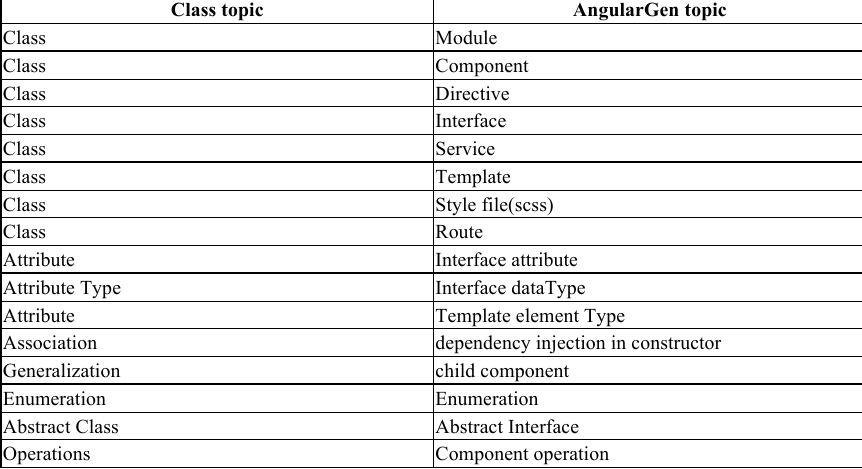
Table 1. Correspondence table between AngularGentopic and class diagramtopics